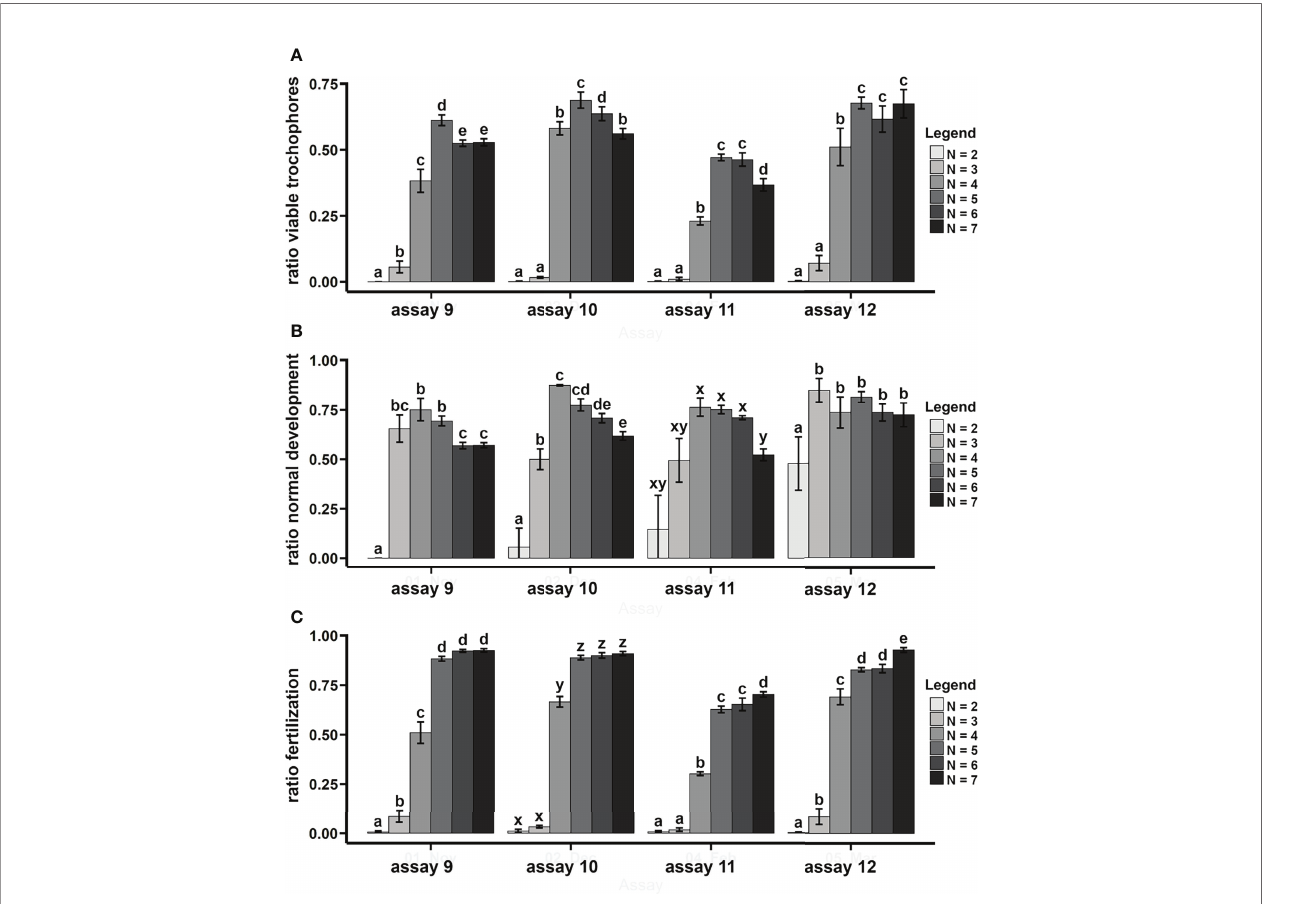
FIGURE 8 | P. aspera . In fl uence of the sperm concentration on the larval production. Treatments were based on logarithmic increments on the sperm concentration: 10 N sperm cells ml − 1 ; N = 2, 3, 4, 5, 6 and 7. Bars indicate average ± SD. Different letters indicate signi fi cant differences among treatments ( p < 0.05). Ratio of viable trochophores (A) , ratio of normal development (B) , and ratio of fertilization (C)